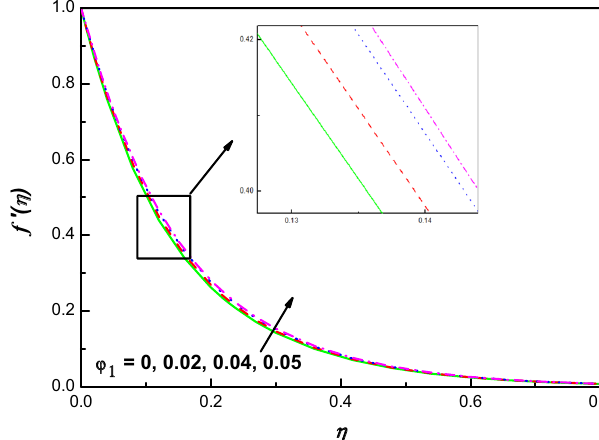
Figure 9. f ′ (η) variation vs. ϕ 1 .